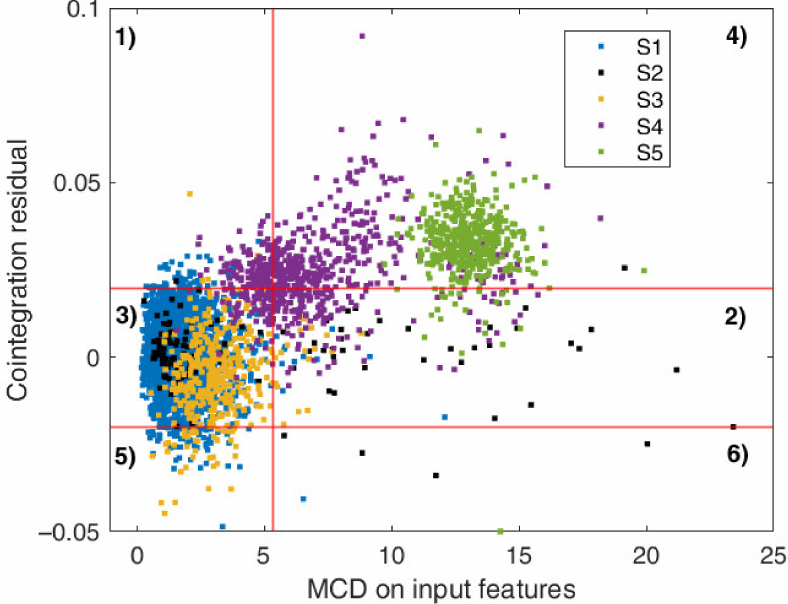
Figure 8. Plot of cointegration residual versus MCD robust distance for model f 2 = h ( f 1 , f 3 , f 4 ) . Numbers from 1 to 6 refer to the different regions of the residual outlier map described in Section